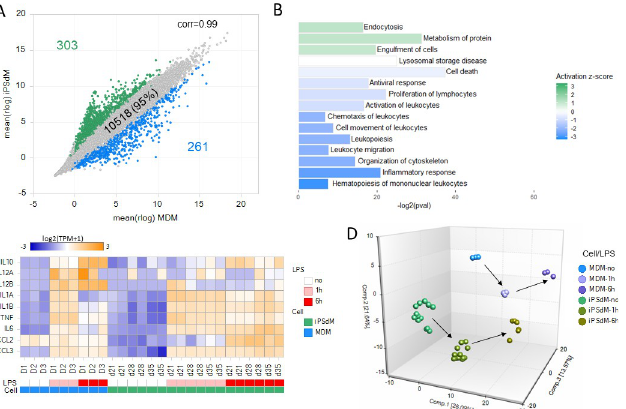
Fig 5. iPSC-derived macrophages and MDM show similar transcriptional and activation profiles. (A) Correlation scatter plot of the average rlog expression values for MDM versus iPSdM. Only genes with TPM > 2 in either group are shown. Genes with fold change > 4 in green and genes with fold change < -4 in blue. (B) Summary of functional groups enriched for the 1964 DE genes. Bar length is the -log2 of the enrichment p-value and the colour represents the z-score with green indicating functions activated in iPSdM relative to MDM and blue bars those activated in MDM relative to iPSdM. (C) Heatmap illustrating changes in expression of 10 LPS inducible genes (left) for both MDM and iPSdM following LPS stimulation. (D) PCA plot iPSdM and MDM samples with and without LPS stimulation. Grey arrows show the progression from no LPS to 1h LPS to 6h LPS.